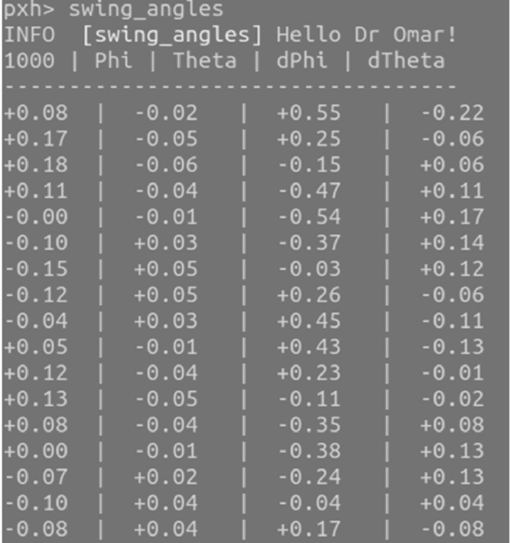
Figure 11. Real-time reading from PX4 terminal.